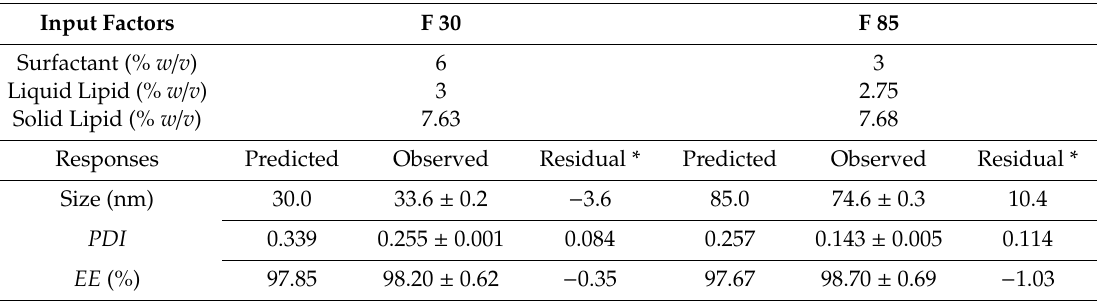
Table 4. Composition of the optimized Ucu ù ba fat NLC formulations F 30 and F 85 along with the predicted, observed and residual values of the responses.